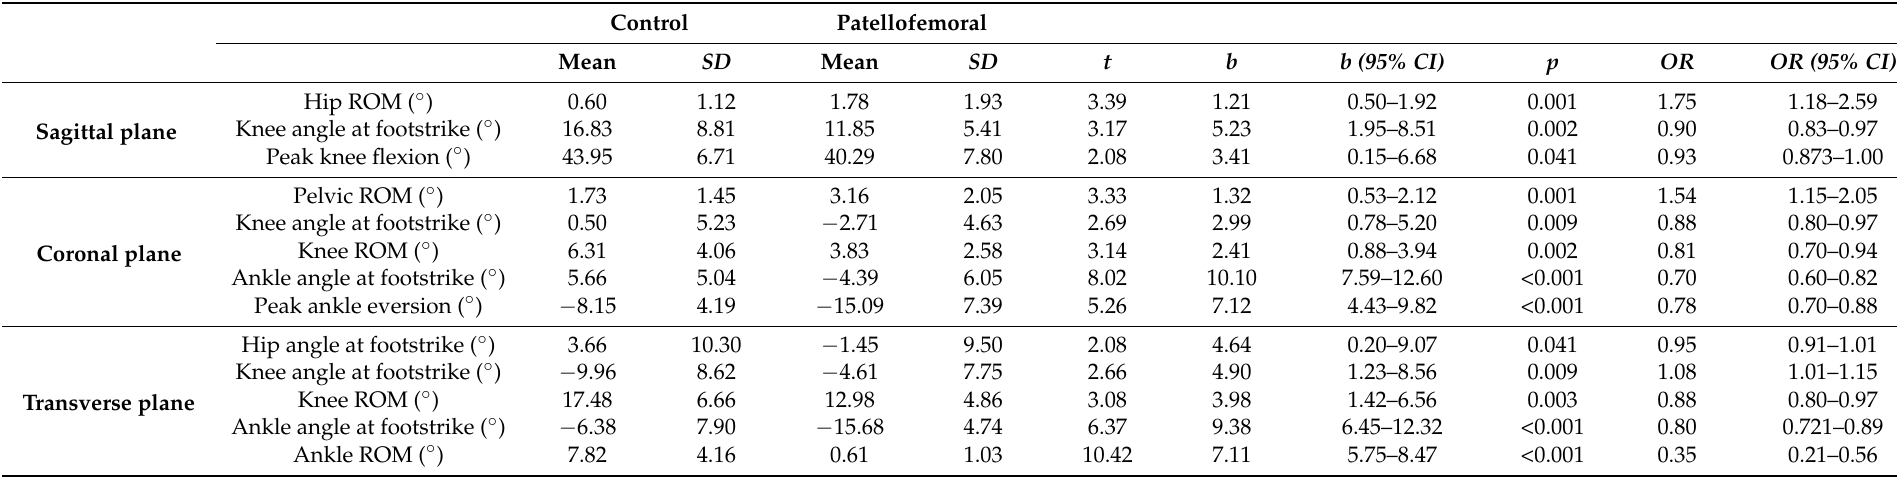
Table 2. Three-dimensional kinematics in overall PFP participants and